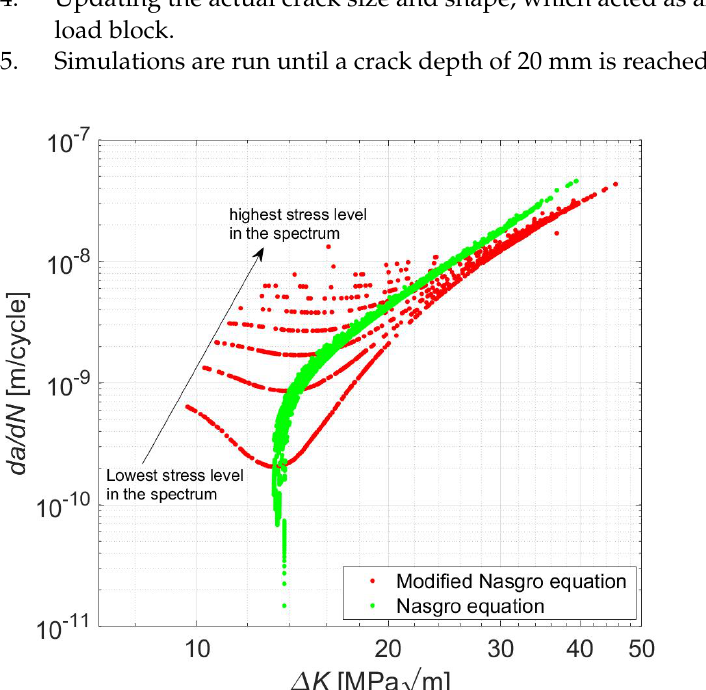
Figure 8. The calculated crack growth rate for Axle S067 by adopting the conventional Nasgro and Modified Nasgro equations at R = − 1 (considering only the rotating bending